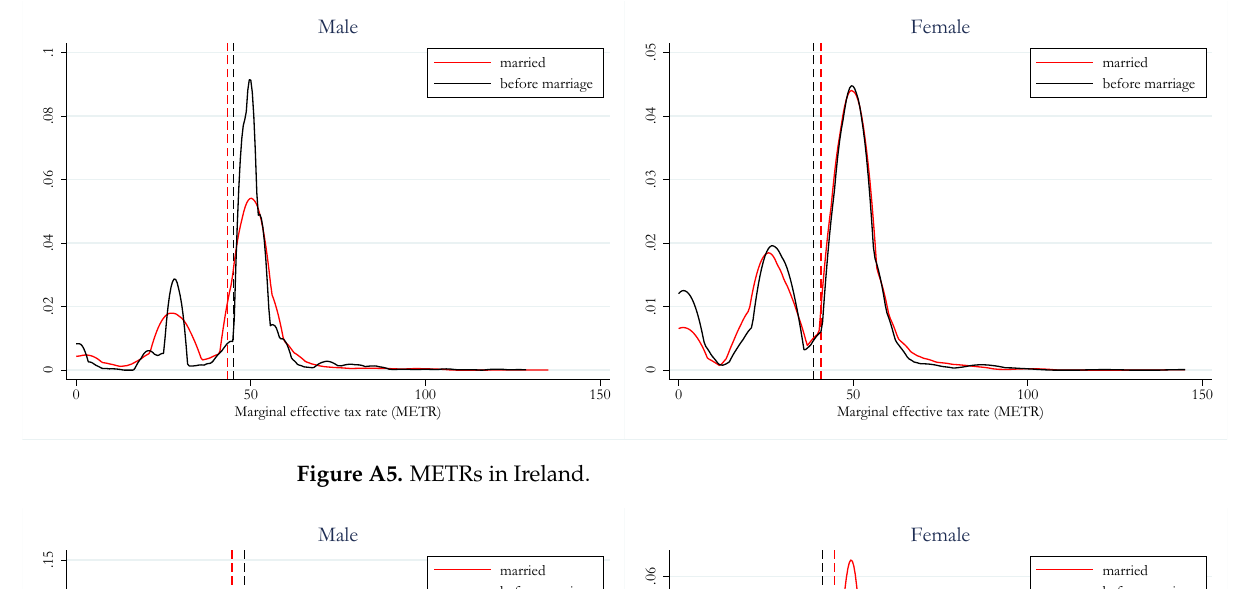
Figure A5. METRs in Ireland.